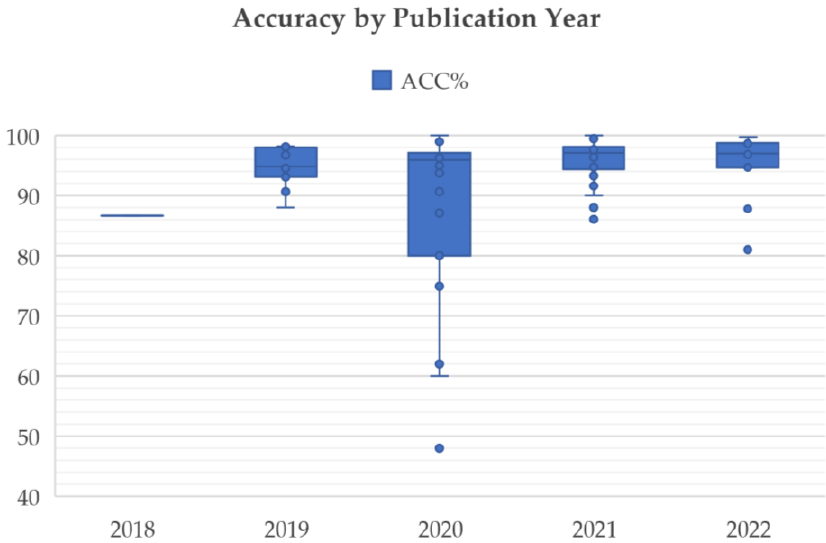
Figure 7. Classification accuracy by publication year.